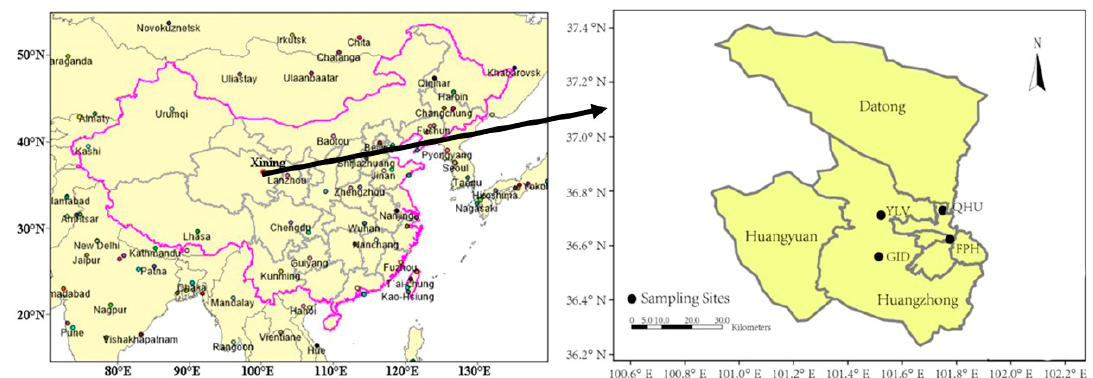
Figure 1. Sampling-site locations.